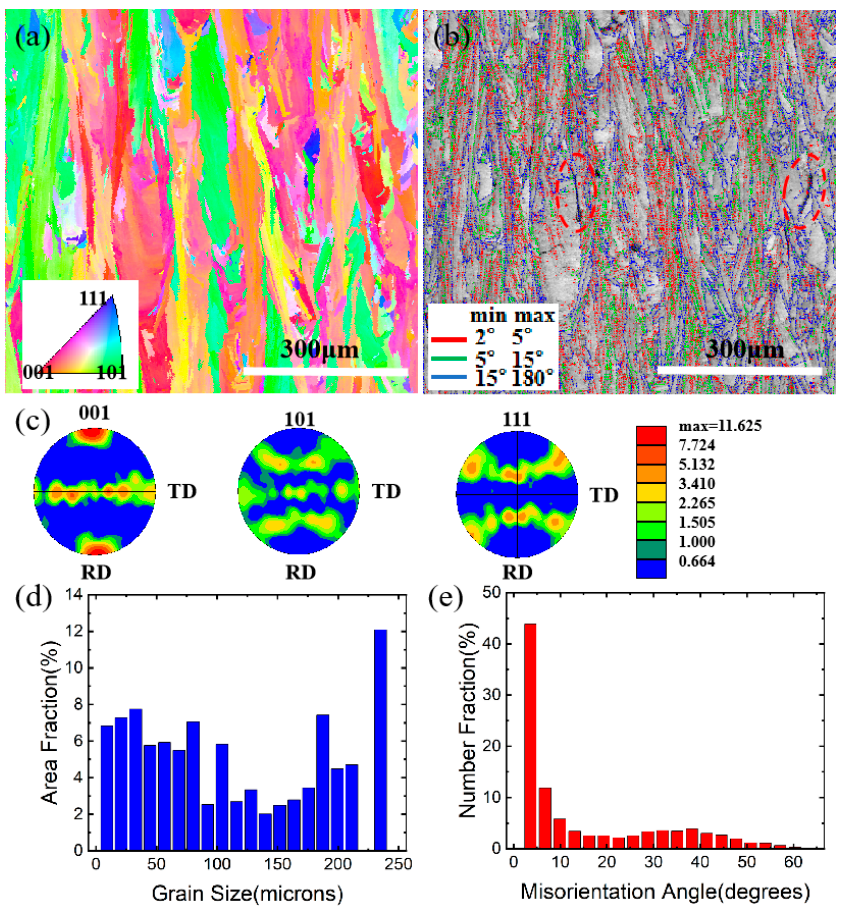
Figure 4. EBSD analyses. ( a ) grain morphology; ( b ) grain boundary angle distribution; ( c ) inverse pole figure; ( d ) grain size statistical diagram; ( e ) grain boundary angle statistical diagram.